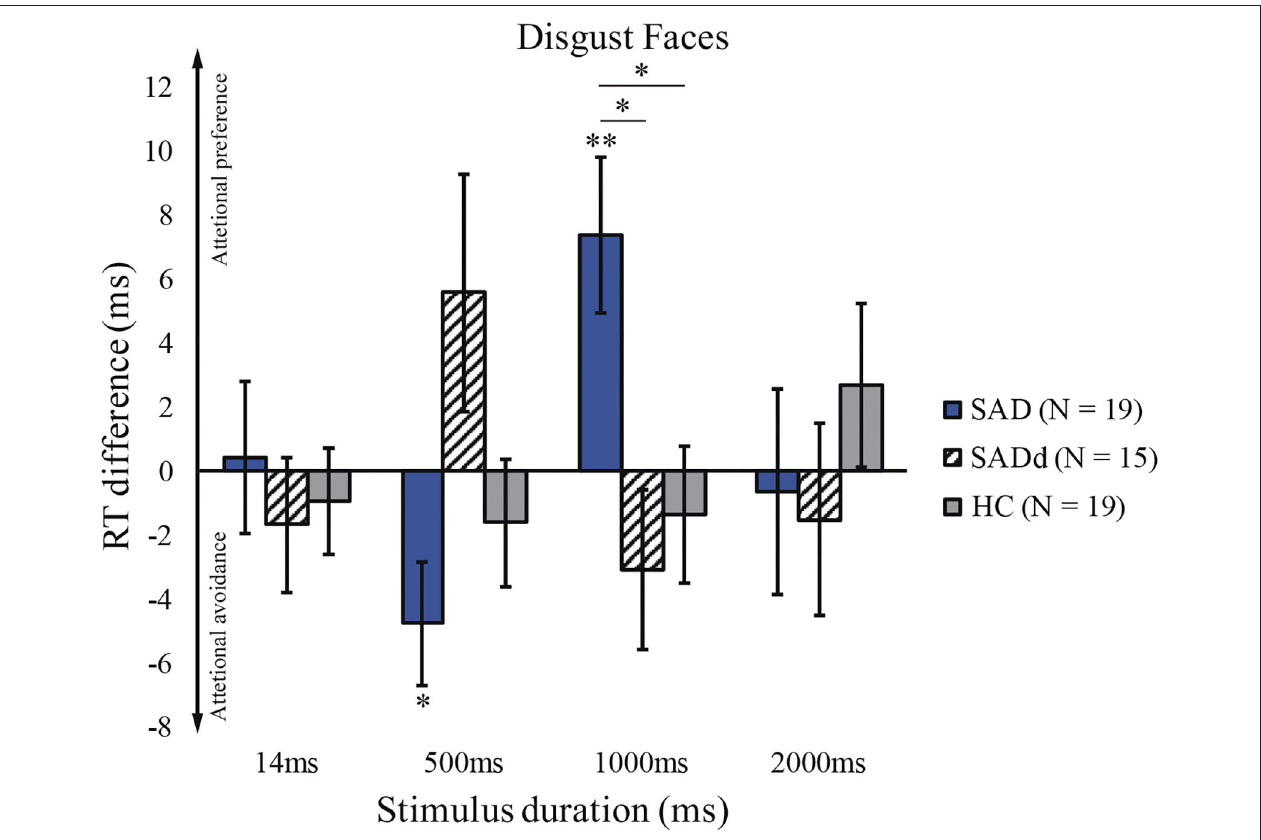
FIGURE 3 | Reaction time difference across groups and stimulus durations for disgusted faces. Figure conventions are ** p < 0.01, * p < 0.05 (two-tailed). These conventions are kept in all subsequent figures.